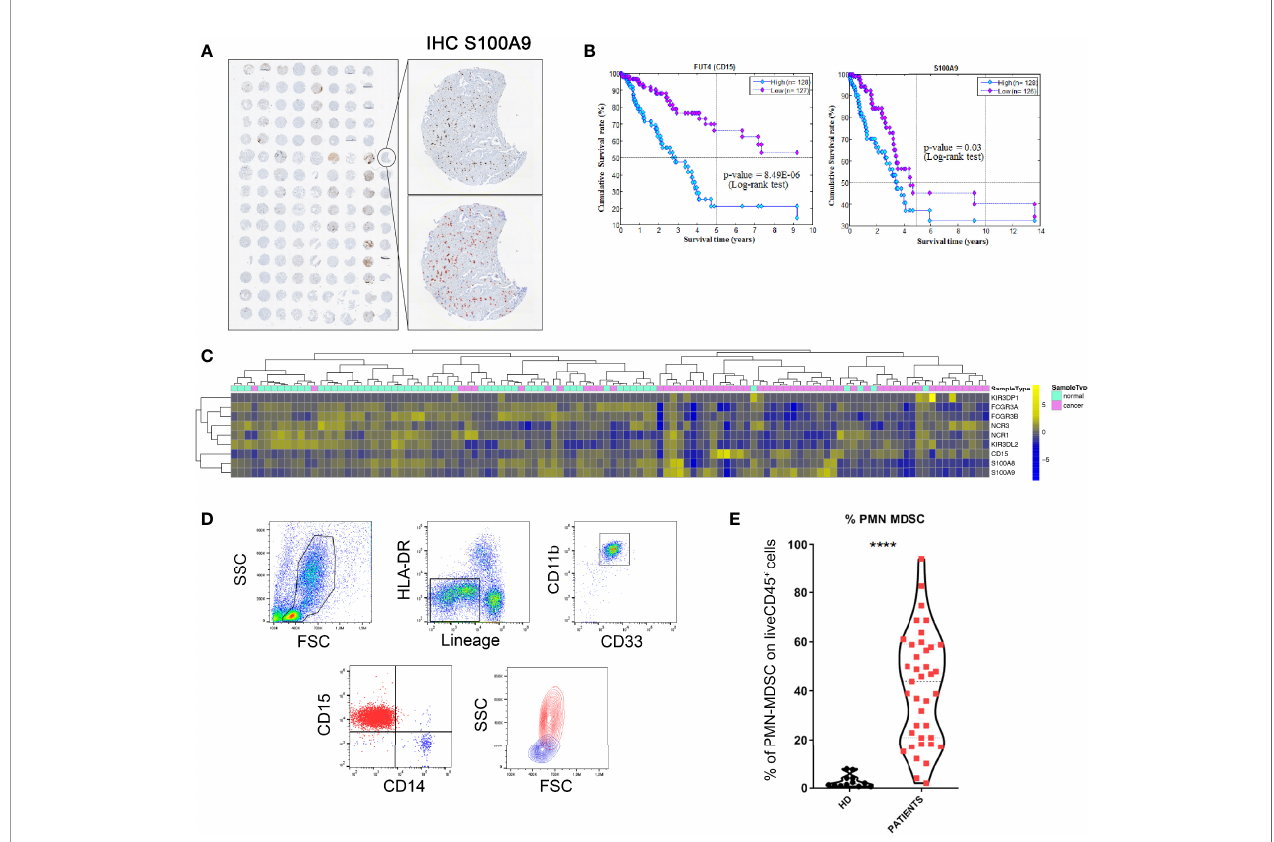
FIGURE 1 | PMN-MDSC are present in high frequency in PB of patients with primary and metastatic lung tumor and correlate with their overall survival. (A) TMA of lung adenocarcinoma cases stained with S100A9 showing positive cells digitally quanti fi ed within tissue cores. The magni fi cation shows S100A9 (upper panel) and S100A9 + cells automatically indicated with red circles (lower panel) to perform a cell count in each core using QuPath (absolute numbers of S100A9 + per mm 2 ). (B) Kaplan-Meier survival analysis. Kaplan-Meier analyses to evaluate the correlations between the expression level of CD15 and S100A9 and the Overall Survival in lung adenocarcinoma patients retrieved from TCGA. Low- and high-expression groups refer to patients with expression levels lower than the 25 th percentile (violet curve) and greater than the 75 th percentile (cyan curve), respectively. (C) Hierarchical clustering and heatmap for KIR3DP1, FCGR3A, FCGR3B, NCR3, NCR1, KIR3DL2, CD15, S100A8, and S100A9 in 57 lung adenocarcinoma samples (violet bars) and 57-matched normal samples (water blue bars) retrieved from TCGA. The expression pro fi les of genes are clustered according to rows (genes) and columns (samples) by using the Pearson correlation as the distance metric and the complete- linkage as clustering method. The colors represent different expression levels that increase from blue to yellow. (D) PBMC were analyzed ex-vivo by fl ow cytometry for the expression of speci fi c markers that allow the identi fi cation of PMN-MDSC. One representative experiment out of 34 performed. (E) Percentages of PMN-MDSC (CD15 + cells) in the PB of healthy donors (HD) and lung tumor patients (n=34). ****p ≤